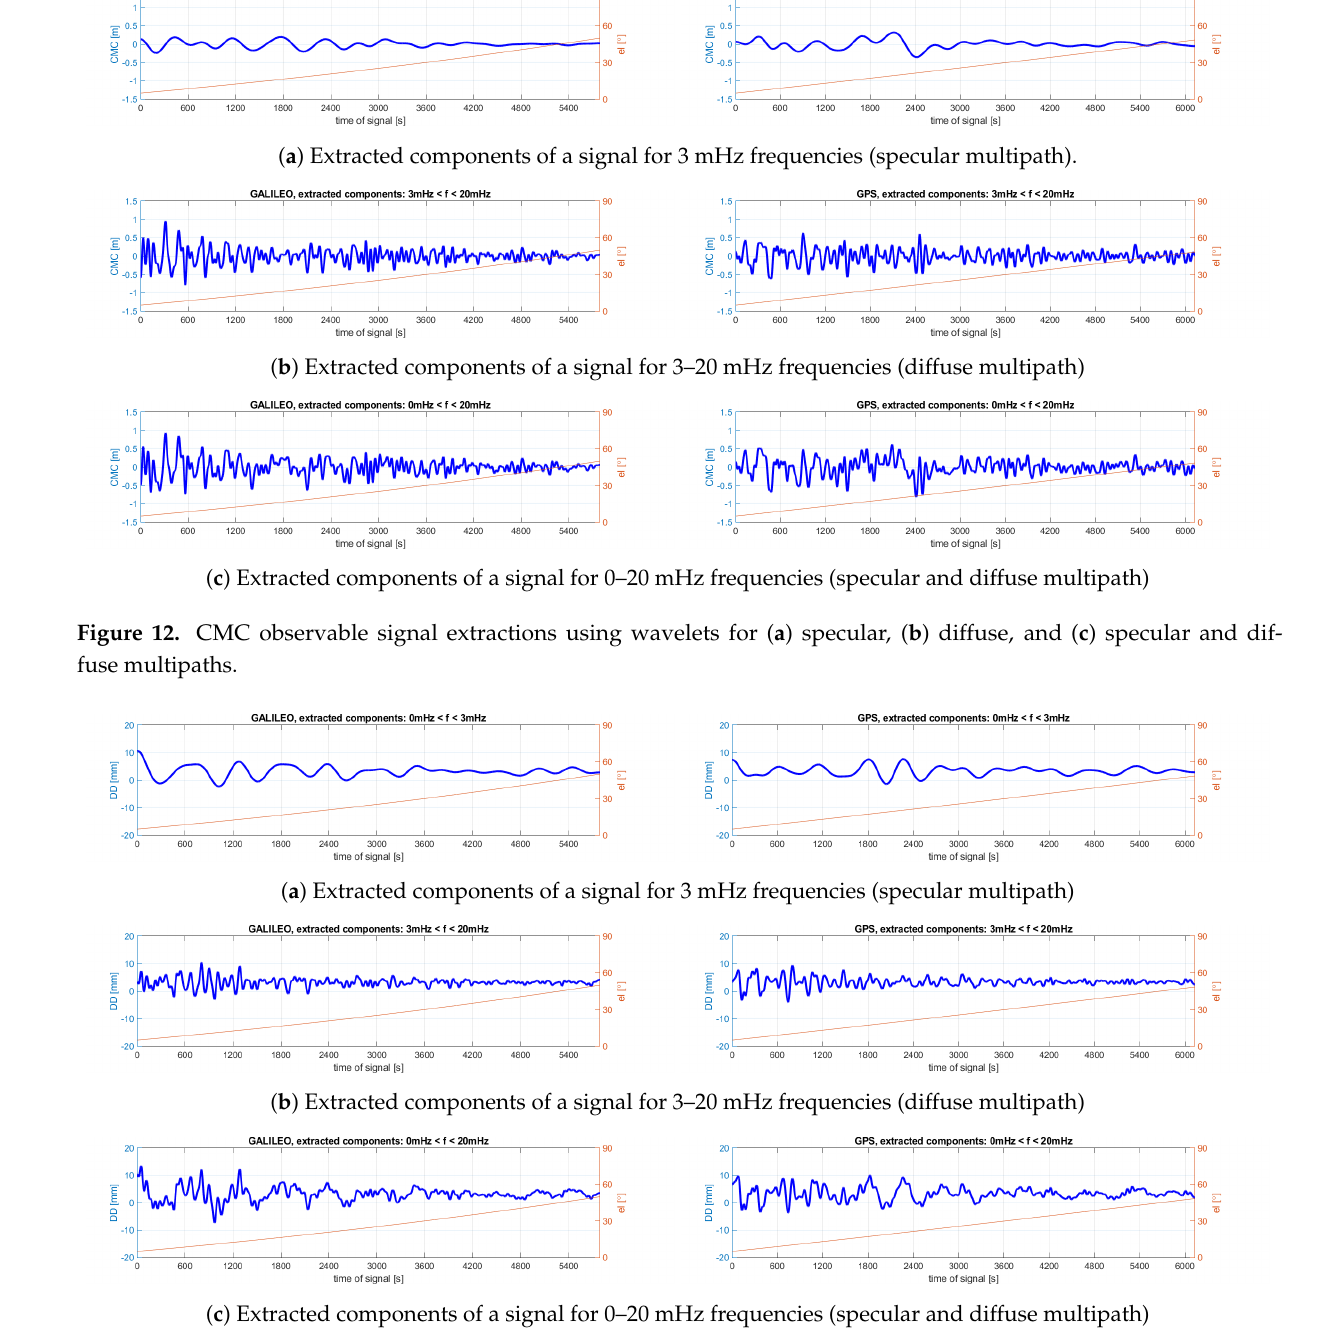
Figure 13. DD phase residual signal extraction using wavelets for ( a ) specular, ( b ) diffuse, and ( c ) specular and dif- fuse